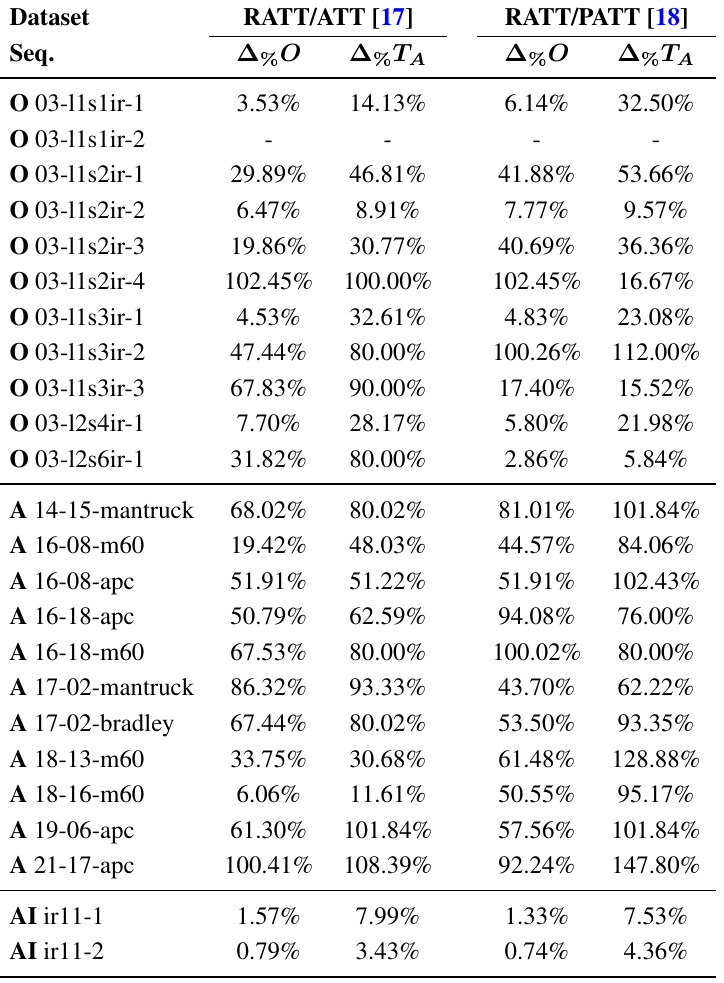
Table 4. A comparison of the number of estimated operations ( ∆ T time per frame ∆ with respect to the reference algorithms, ATT [17] and PATT [18]. A % O, OTCBVS dataset; A, AMCOM dataset; AI, AIC